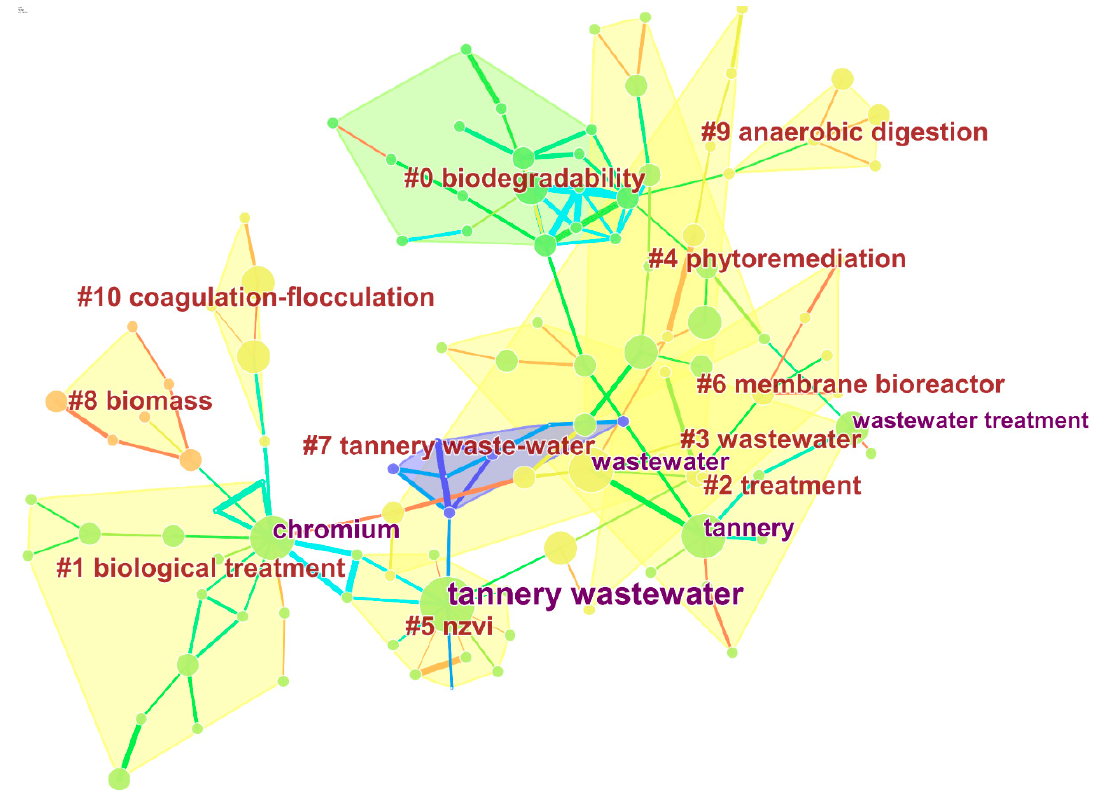
Figure 7. Co-occurrence clusters of the keyword map of tannery wastewater research. It shows that “#0 biodegradability”, “#1 biological treatment” and “#10 coagulation-flocculation” are frequently used terms in tannery wastewater research. In addition, cluster keywords such as “#4 phytoreme- diation”, “#6 membrane bioreactor” and “#9 anaerobic digestion” were also hotspots of tannery wastewater research.